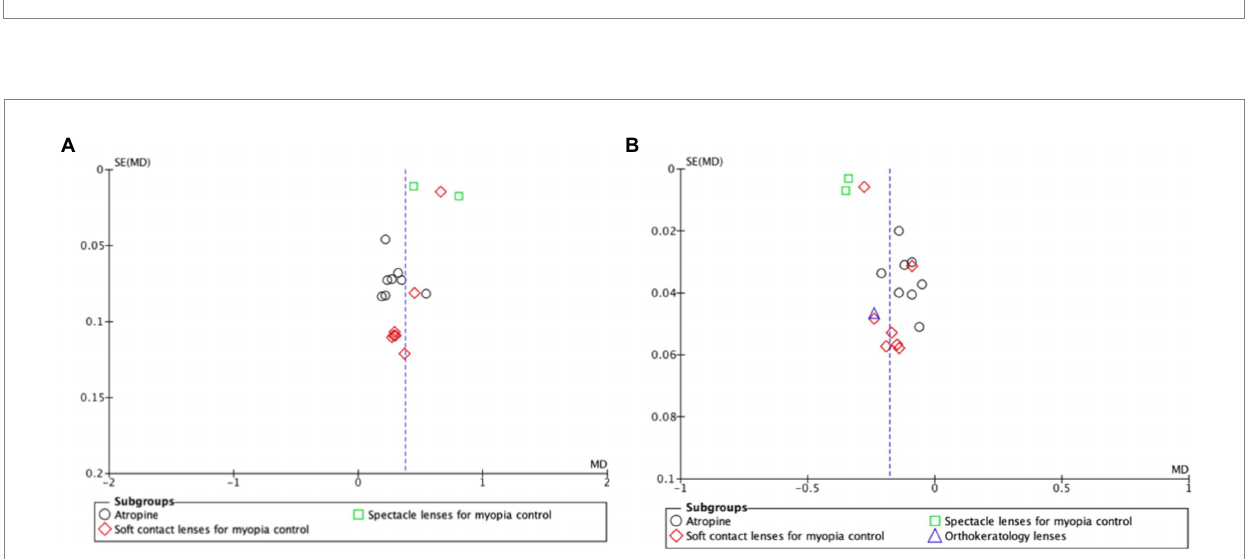
FIGURE 4 Funnel plot of comparison for myopia progression (A) and axial length elongation (B) . The funnel plot is a scatter plot that shows the effect estimates on the x-axis and measures of study precision (or study size) on the y-axis. The blue dotted vertical line represents the estimated common effect. SE, standard error; MD, mean